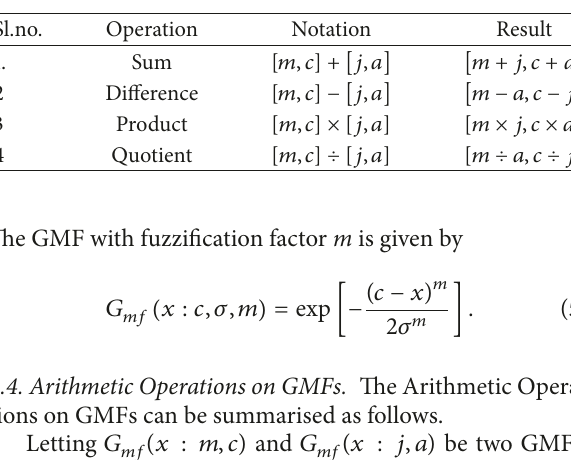
Table 1: Arithmetic operations.